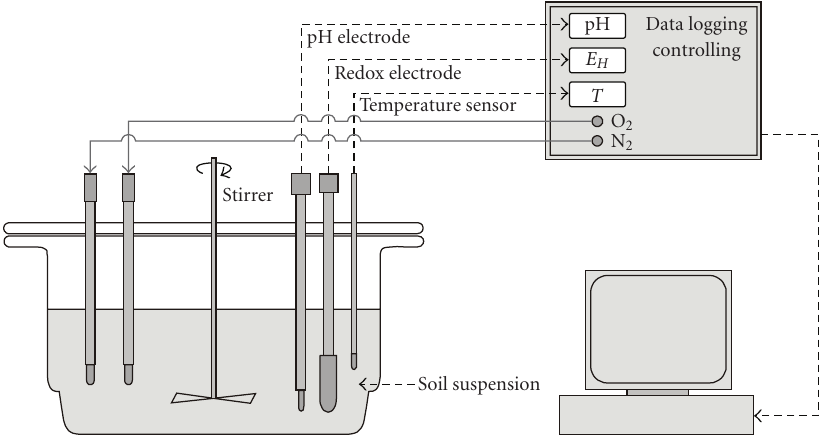
Figure 1: Scheme of a microcosm and control